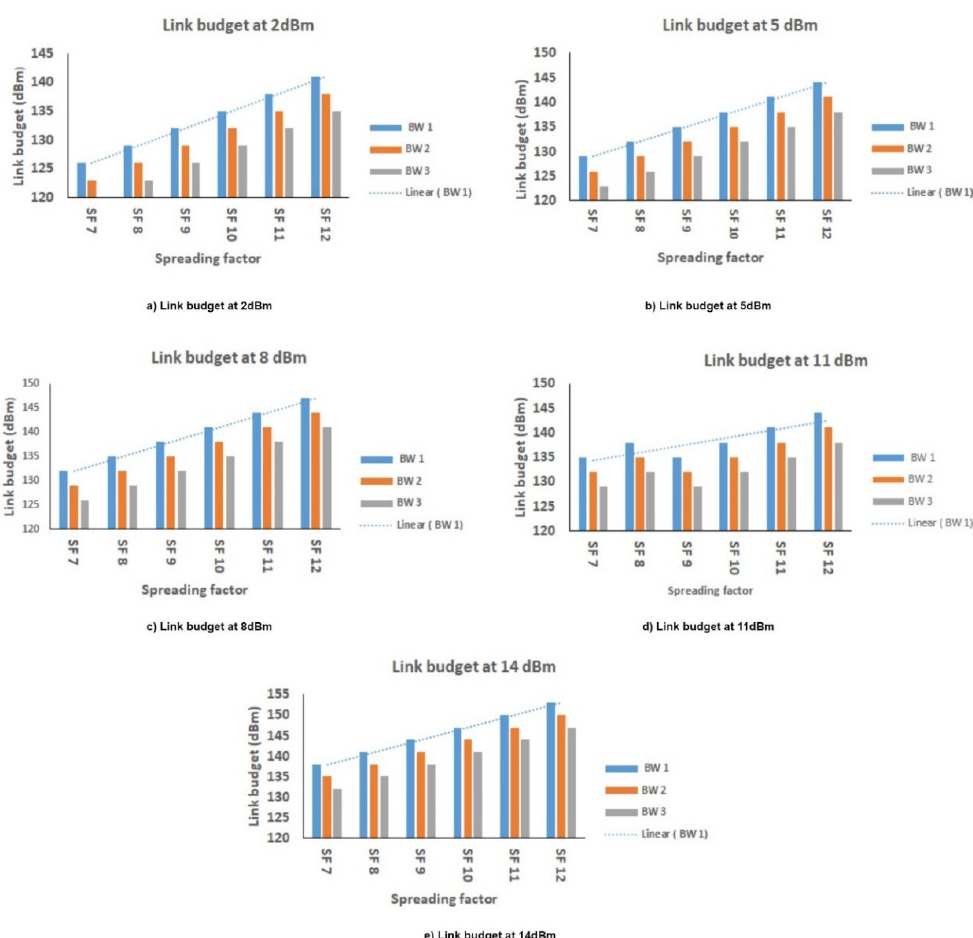
Figure 11. Link budget at distinct transmitter power